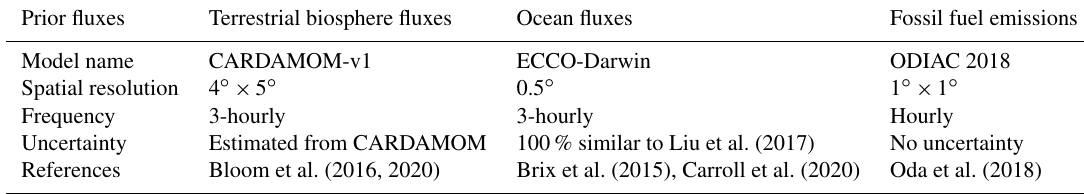
Table 2. Description of the prior fluxes and assumed uncertainties in the inversion system.